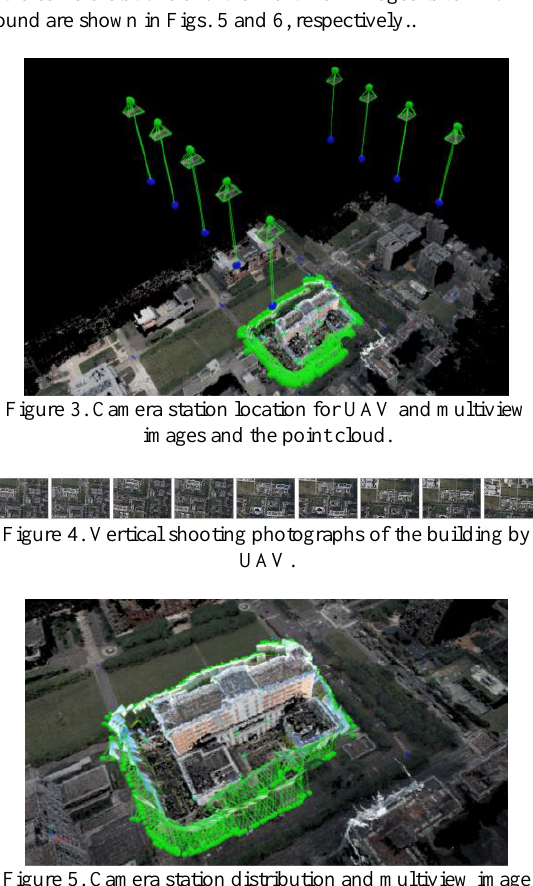
Figure 5. Camera station distribution and multiview image photographs.